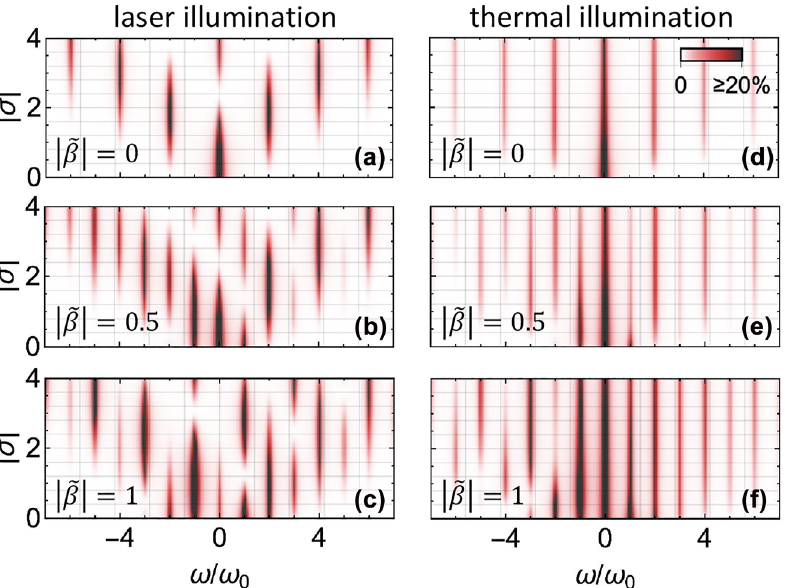
Figure 4: Electron energy-loss spectrum. Electron distribution as a function of the normalized energy loss 𝜔 ∕ 𝜔 ̃𝛽 | = ̃𝛽 | = ̃𝛽 | = 0 (a, d), | 0 . 5 (b, e), and | 1 (c, f). We take the cavity to be initially prepared in either a coherent state (a–c) or a coupling | 𝜎 | for | thermal state (d–f), as described by Eqs. (13) or (14), respectively. The conditions ̄ n ≫ 1 and 𝜙 = 𝜋 ∕ 2 are assumed in all panels, and a ) is introduced for Lorentzian broadening in 𝜔 (FWHM = 0.12 𝜔 0